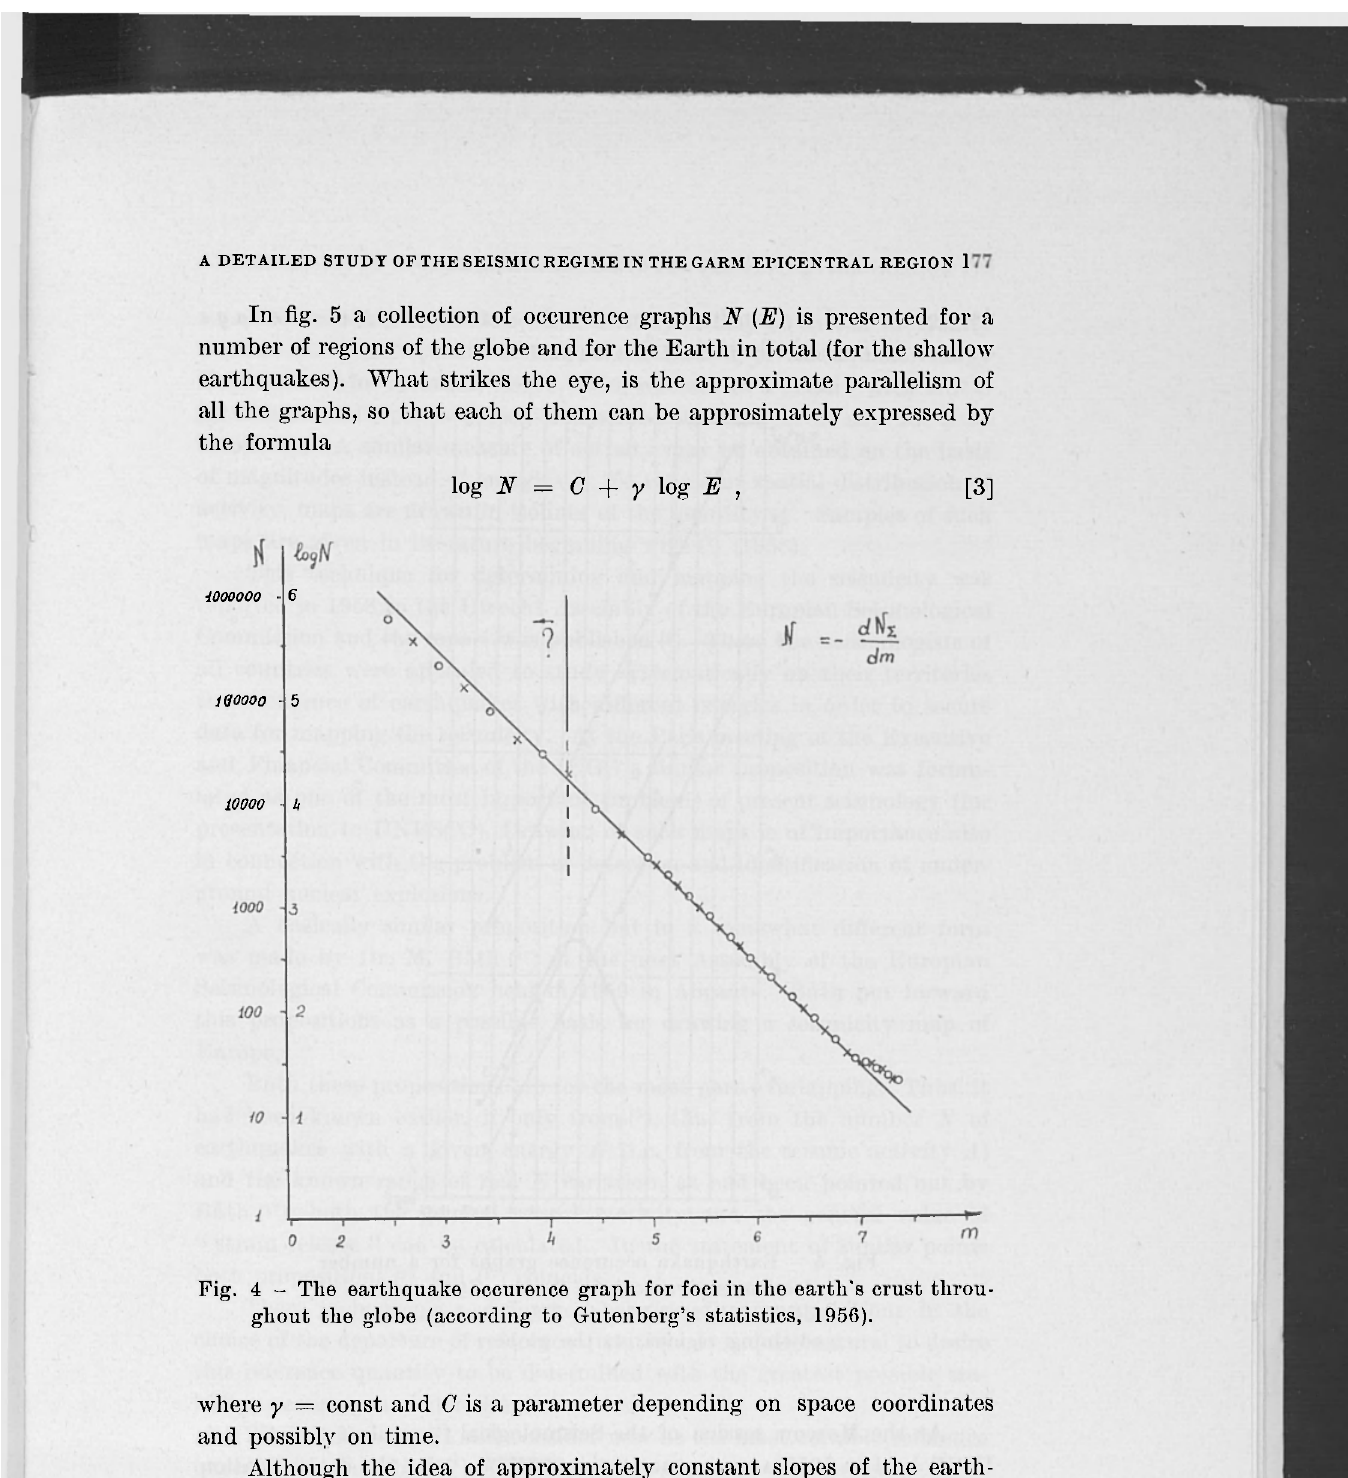
Fig. 4 - The earthquake occurence graph for foci in the earth's crust throu- ghout the globe (according to G-utenberg's statistics,